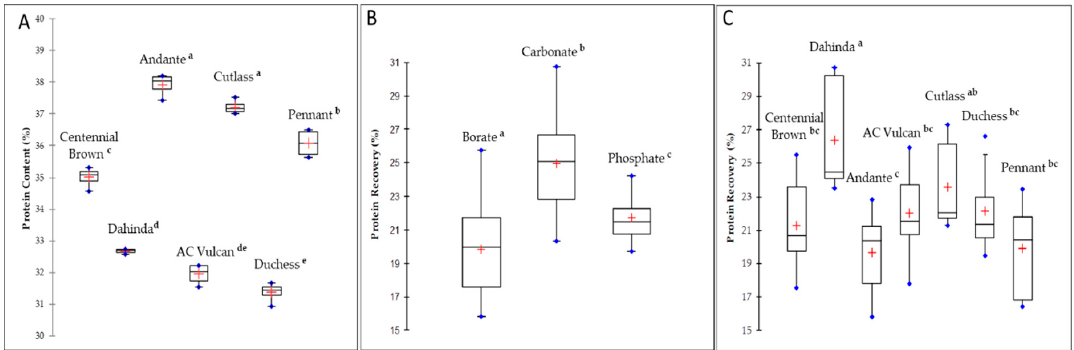
Figure 1. Protein content and extractability from different mustard varieties. Box plots represent the protein content of the studied Canadian mustard varieties ( A ), the effect of extraction buffer on mustard protein recovery ( B ), and the effect of mustard variety on protein recovery ( C ). Buffers or varieties with different superscripts are significantly different (Tukey multiple comparison of means, p <